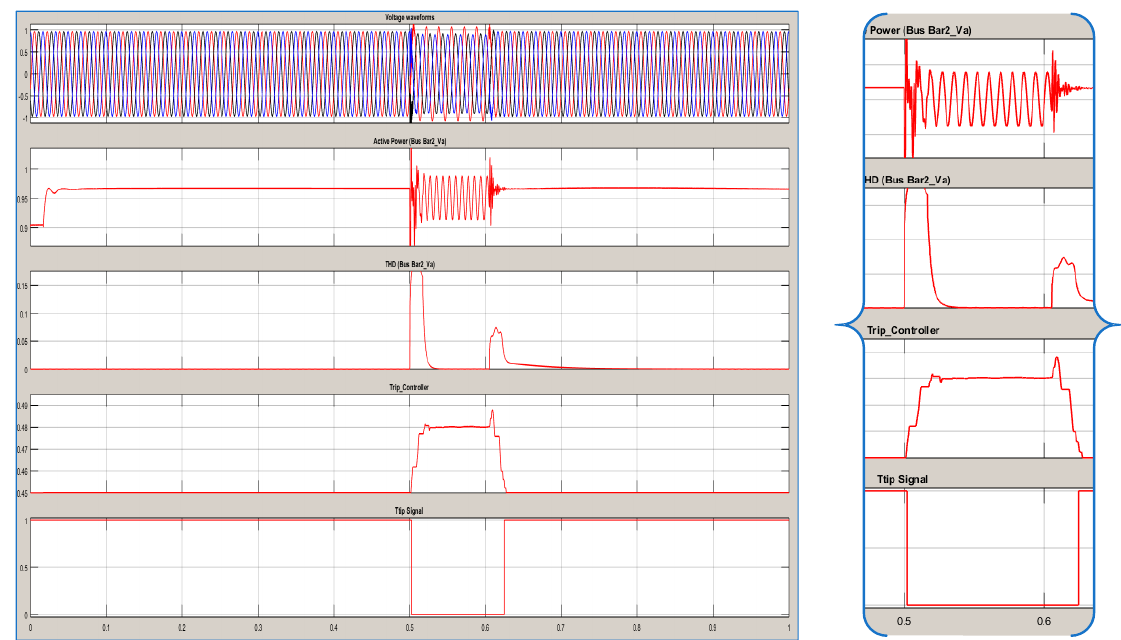
Figure 13. Single line to ground (C_G) fault voltage waveform.